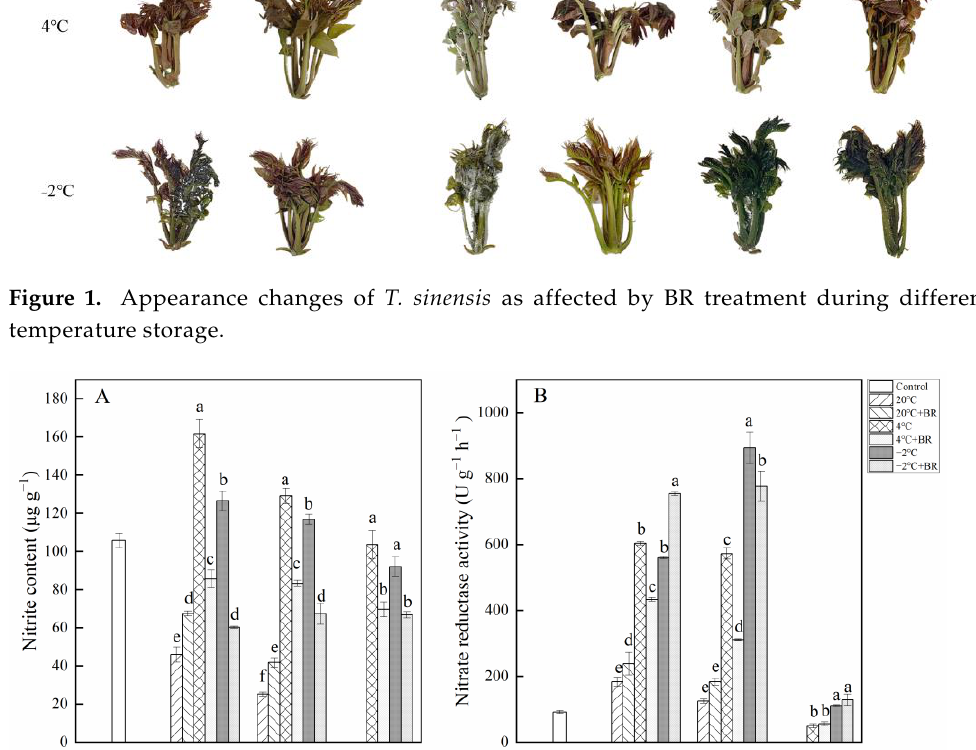
Figure 2. Effects of BR treatment on nitrite content ( A ) and nitrate reductase activity ( B ) of T. sinensis during different temperature storage. Bars with different letters are significantly different at the same storage time under different temperatures and BR treatment ( p < 0.05). Values are the mean of four replicates ± SE.